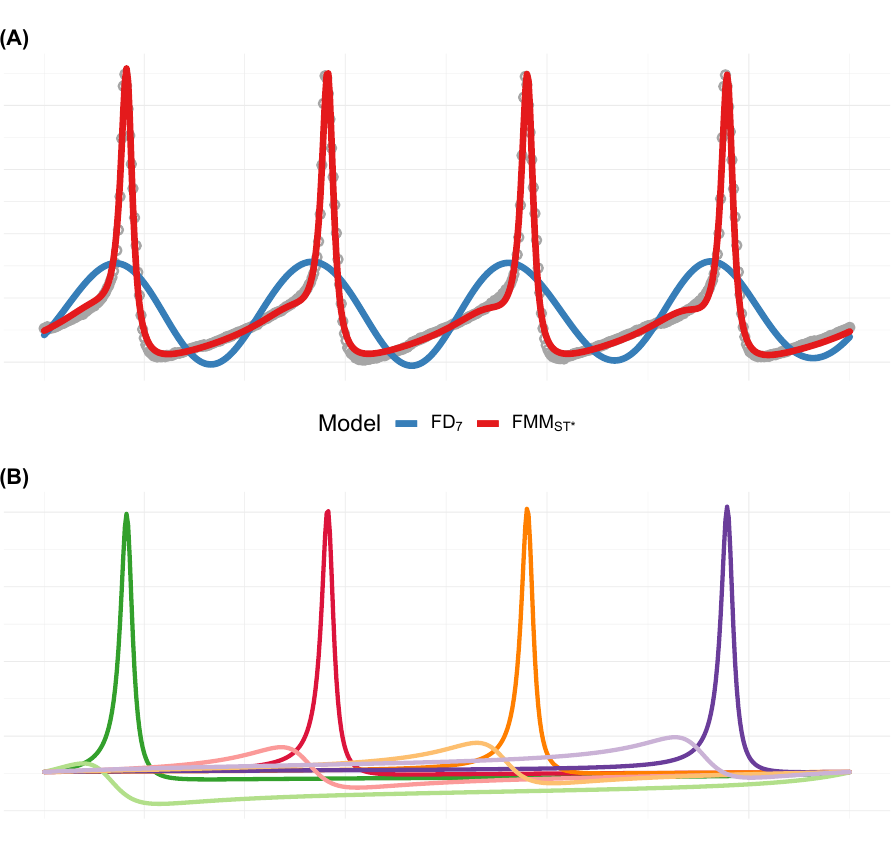
Figure 3. AP train from Squid Giant with experiment number a 1 t 18 2 . ( A ): Observed data (grey open circles), FD (blue lines) and FMM (red lines) model prediction. ( B ): FMM wave